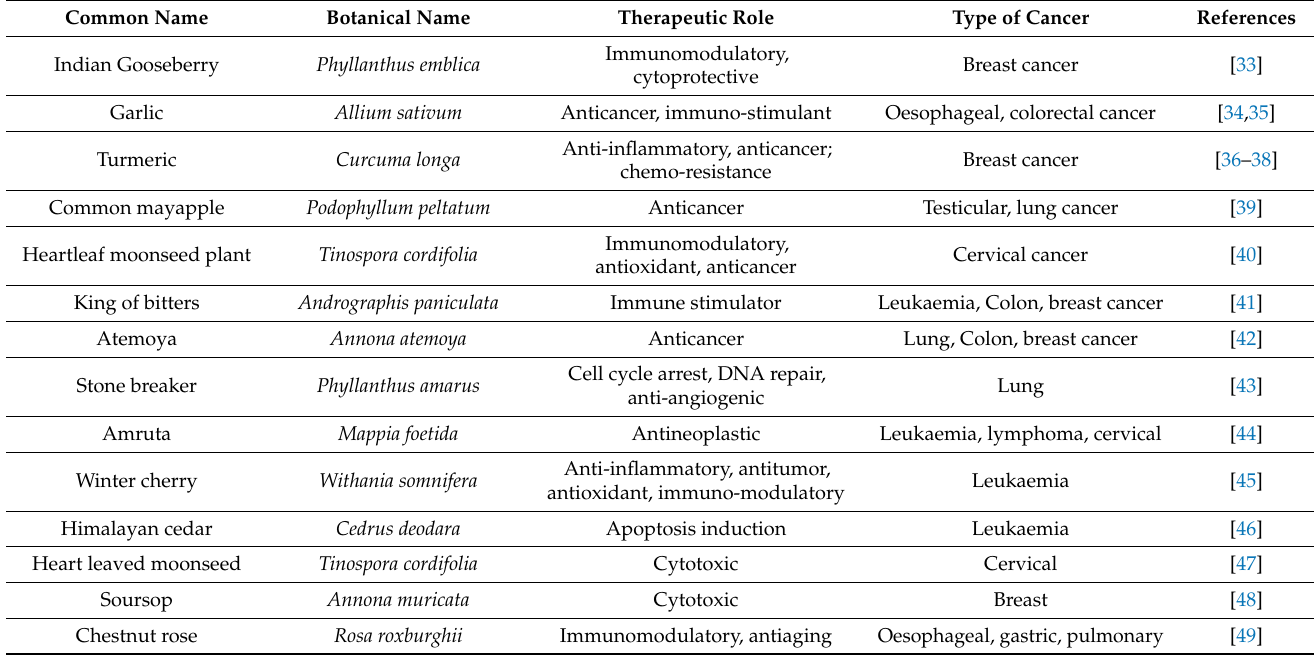
Table 1. Medicinal plants used in chemoprevention of cancer and their therapeutic